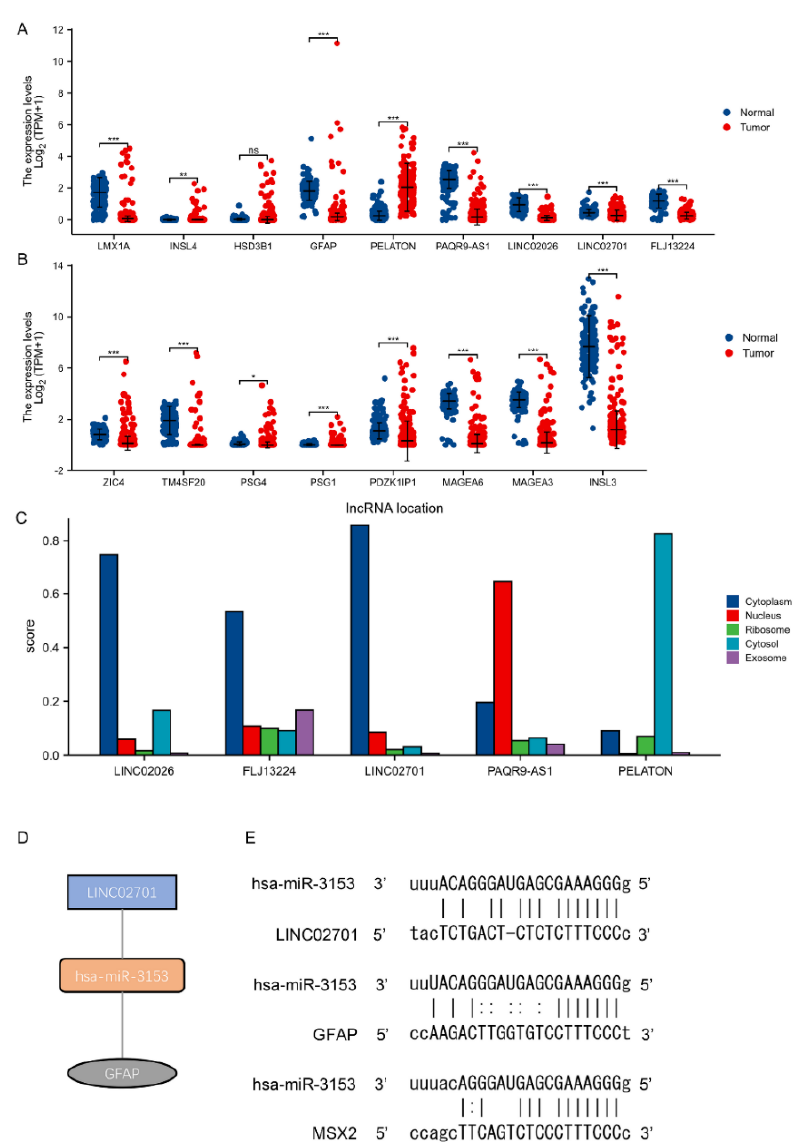
Figure 5. validation of ceRNA network ( A , B ) Expression of hub lncRNAs and mRNAs of the triple regulatory network in the TCGA TGCT dataset ( C ) Predicted cellular localisation of 5 hub-lncRNAs with lncLocator ( D , E ) Base pairing between LINC02701-has-miR-3153-GFAP. (*, p < 0.05; **, p < 0.01; ***, p < 0.001)